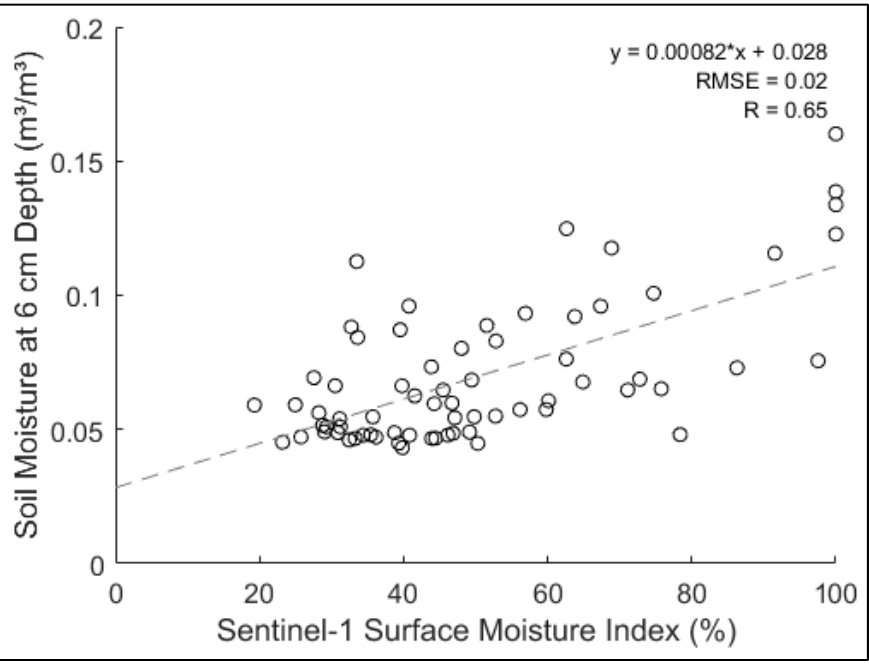
Figure 5. Comparison of in situ soil moisture information and the Sentinel-1-derived surface moisture index (SurfMI) ( N = 69). The regression line is shown in dashed grey. * is a multiplication symbol.